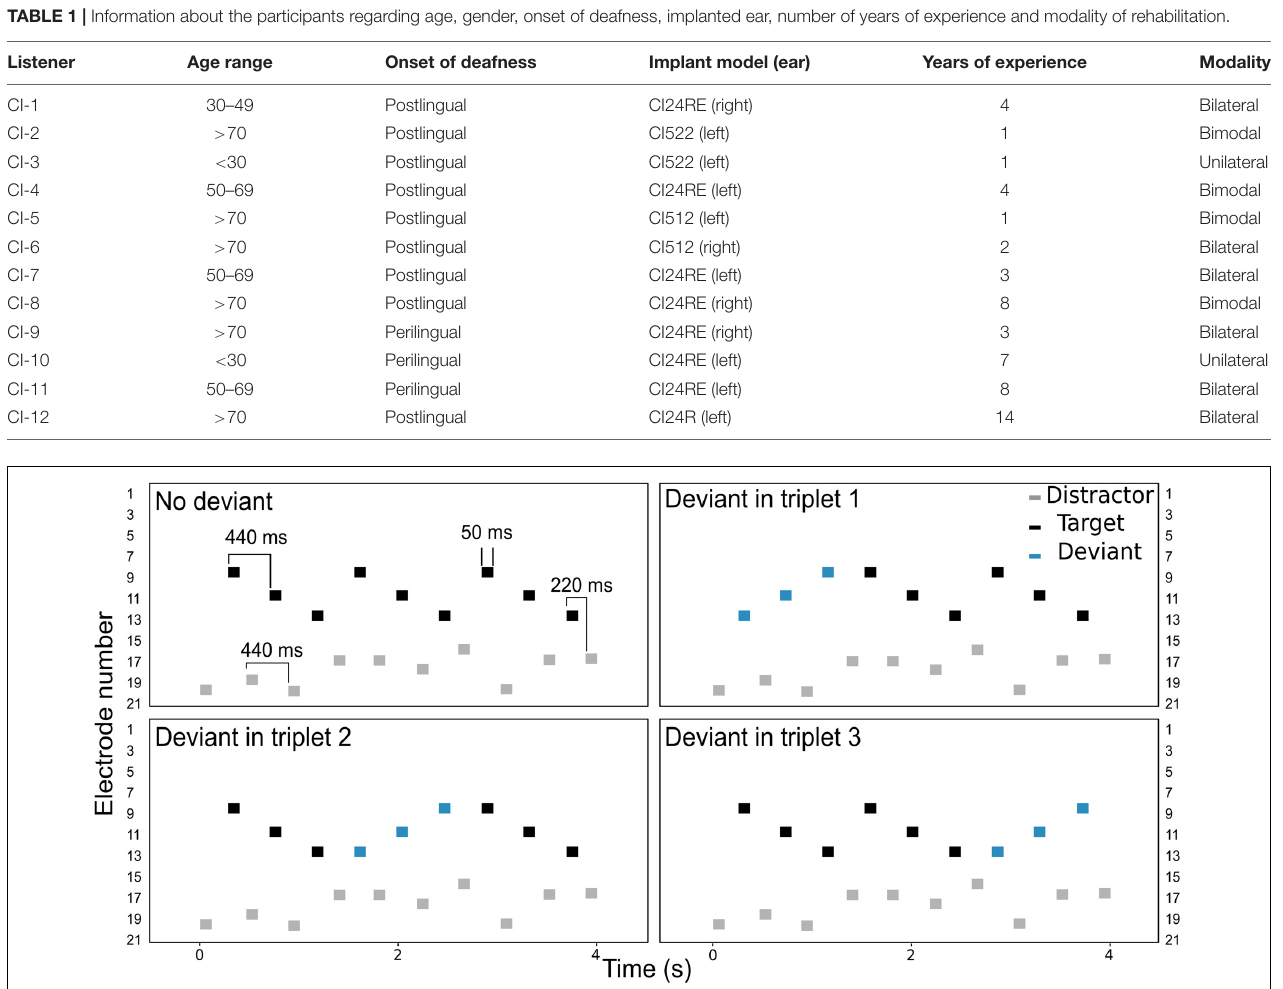
FIGURE 1 | Schematic representation of the electrodogram for each of the four deviant conditions. Black and gray markers represent the target and the distractor sounds, respectively. The deviant triplet is shown with blue